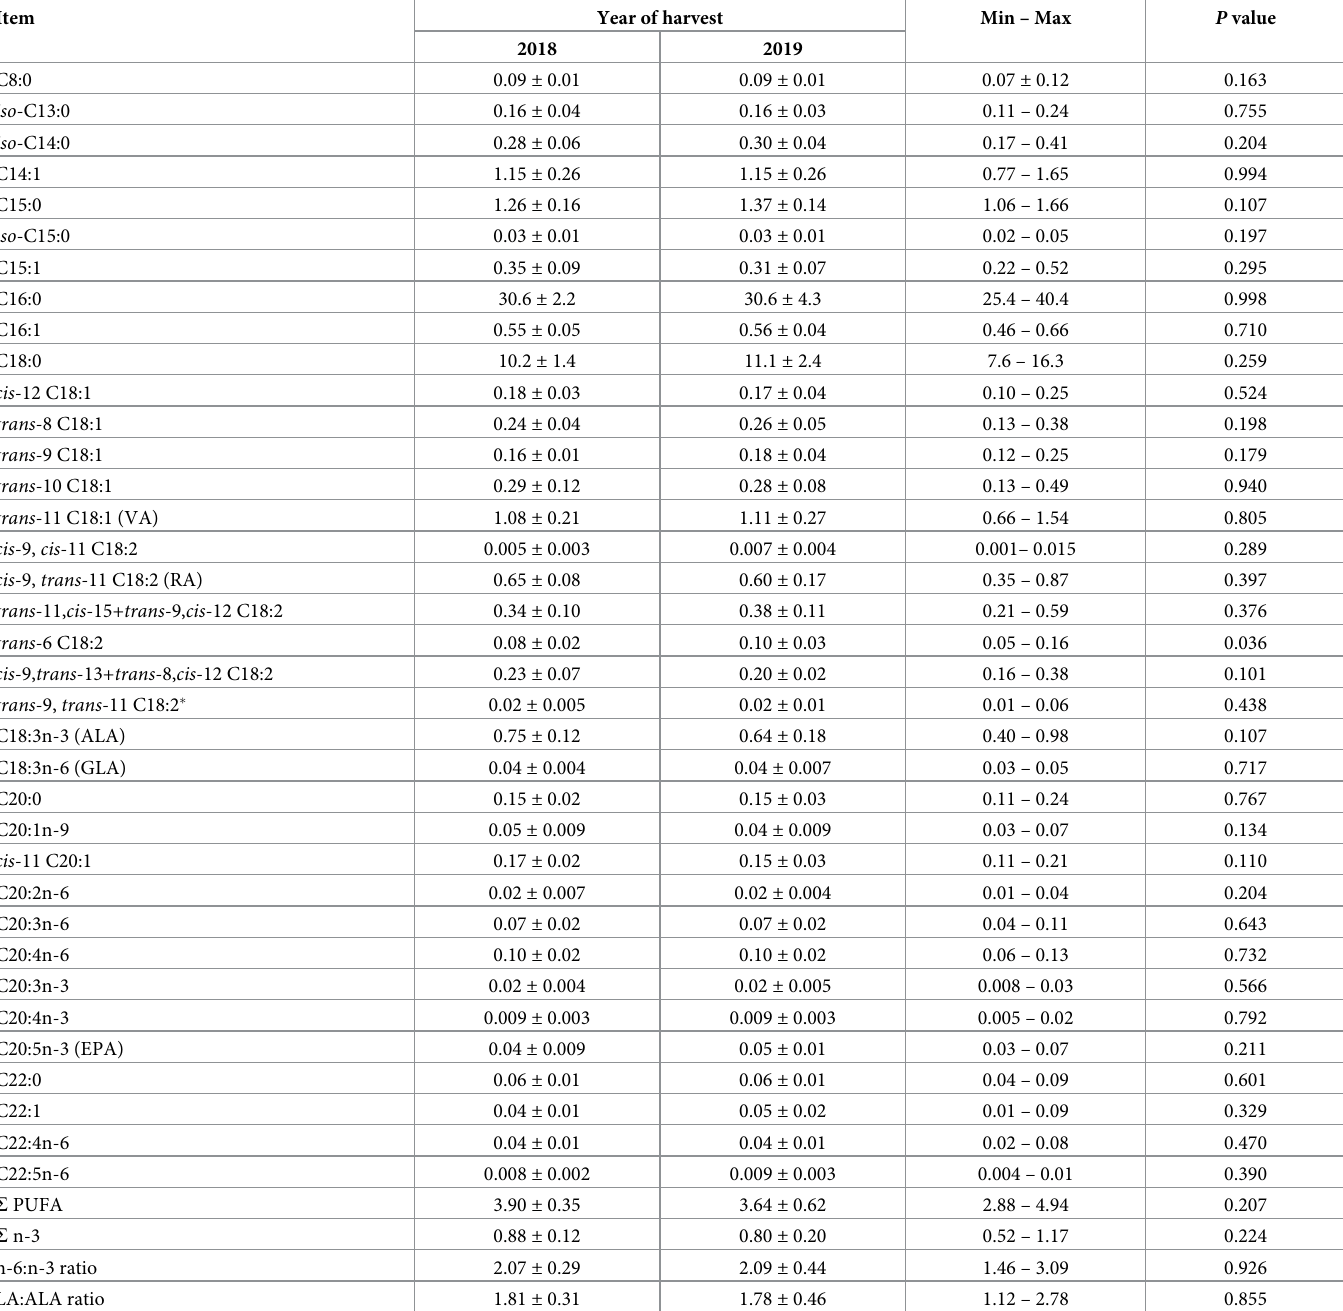
Table 3. Individual milk fatty acids or groups of fatty acids (g/100 g of total FAME) proportions unaffected by the year of harvest of grassland-based feeds as ana- lyzed by GC.